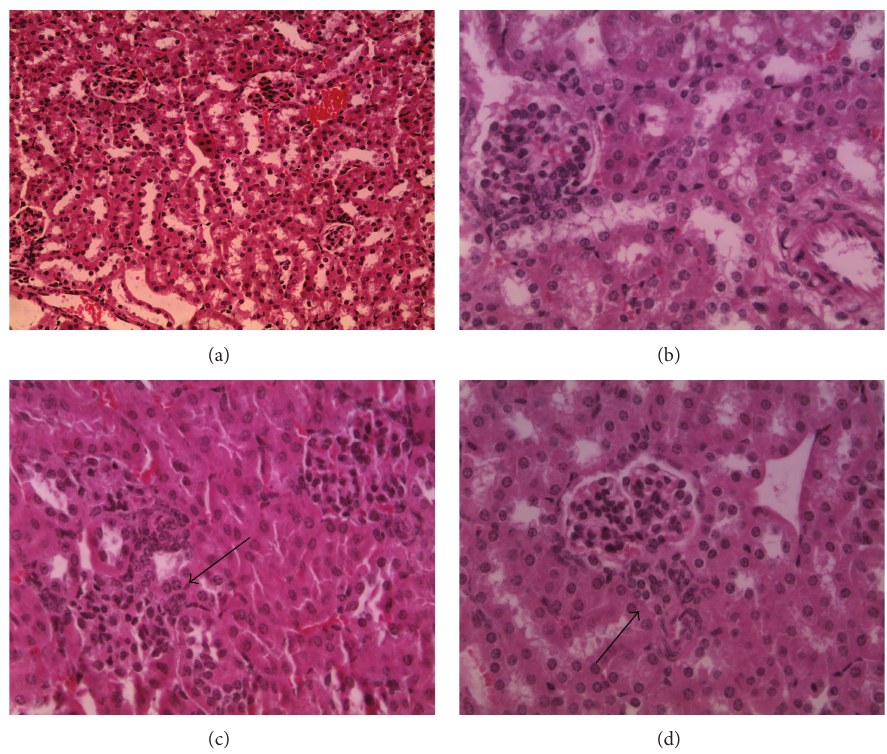
Figure 4: Kidney sections. (a) Control, magnification 20x; (b) low concentration, magnification 40x; (c) media concentration, magnification 40x; (d) high concentration, magnification 40x. The histological structure of the organs appeared normal except for the media concentration where lymphoid cells are present